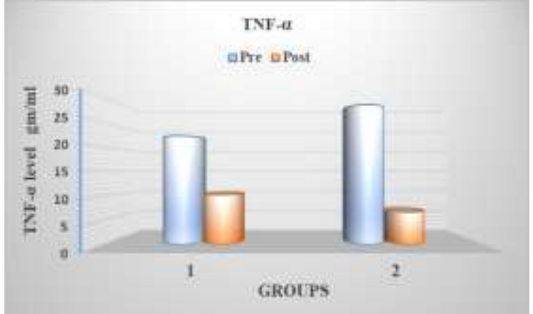
Figure 4.Effect of treatment on TNF-α levels in patients with diabetic